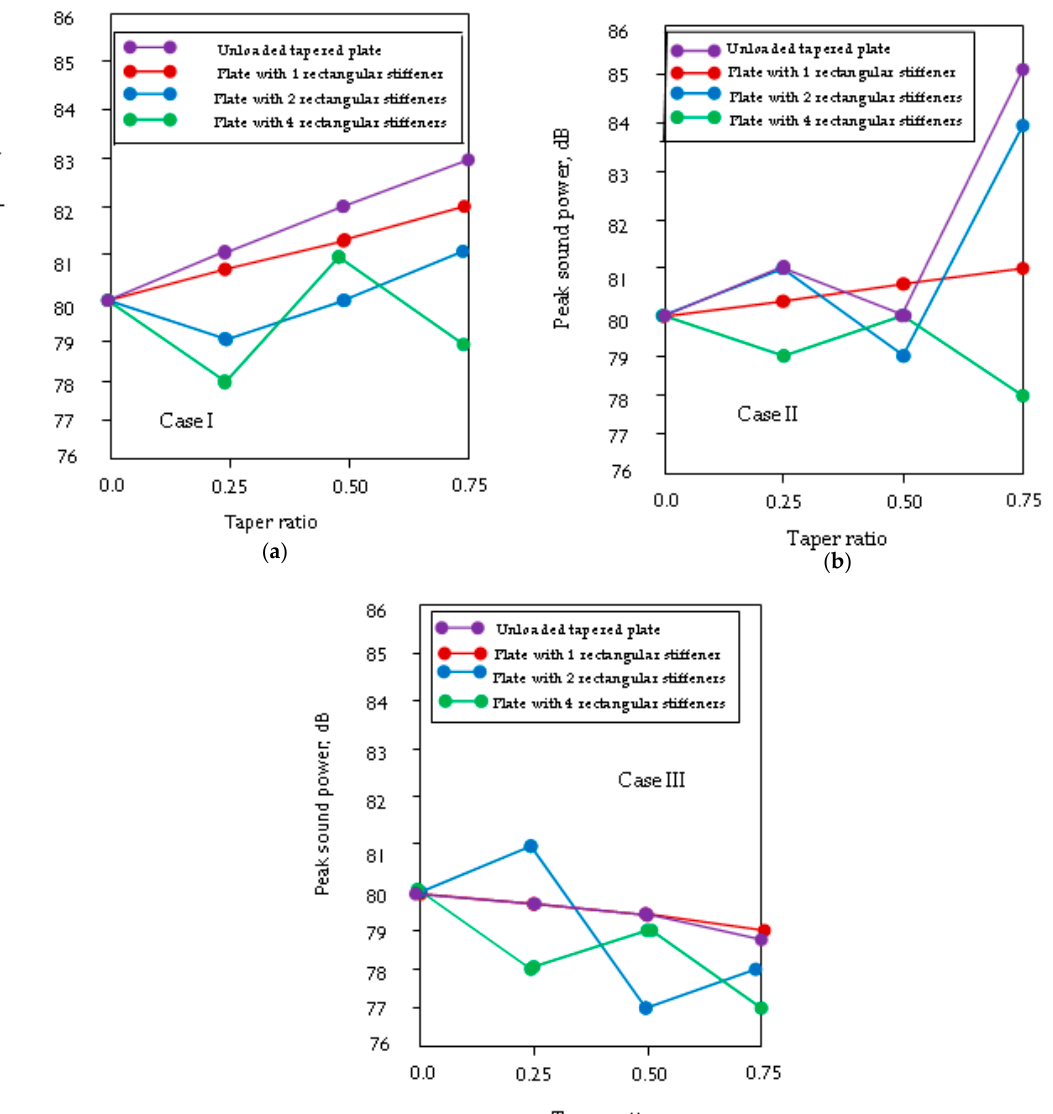
Figure 28. Comparison of peak sound power level (dB) for ( a ) Case I, ( b ) Case II, and ( c ) Case III plates having different parabolic thickness variations with different attachments of rectangular stiffener patches.